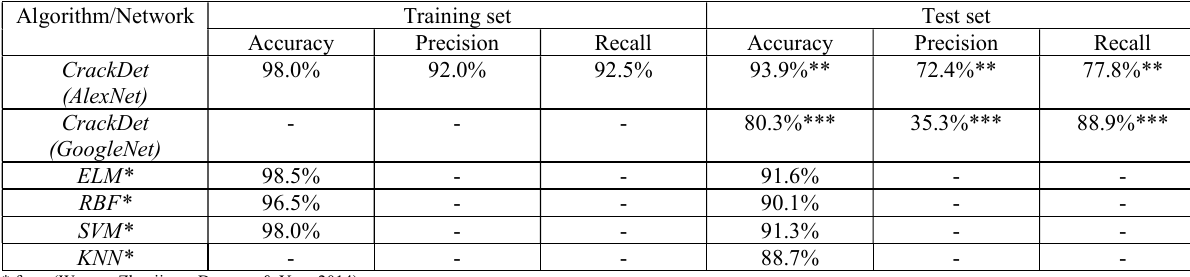
Table 2: comparison of different Algorithms/Networks in terms of accuracy of the prediction.